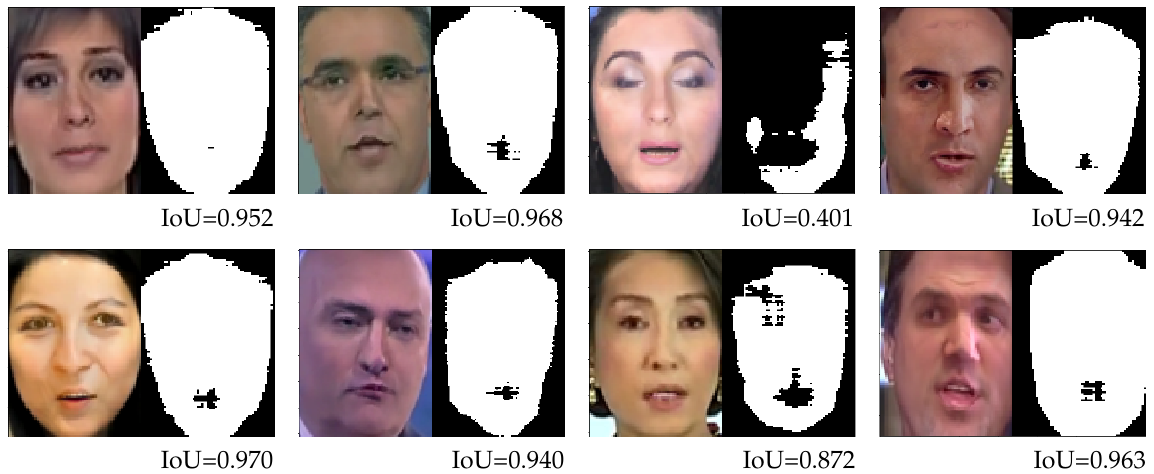
Figure 10. Randomly selected images from the result of detecting the fake images by the model trained with the FaceSwap dataset. The left side images of every pair of sub-images is the fake images and the right side images of every pair of sub-images is the prediction result.